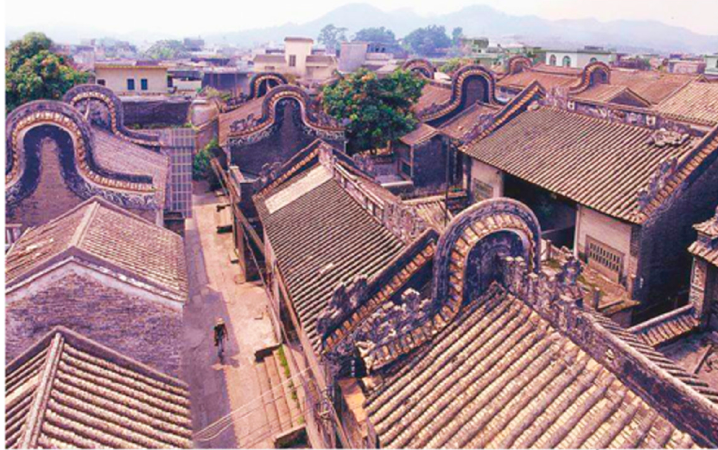
Figure 3. Shawan buildings (Source: the authors).